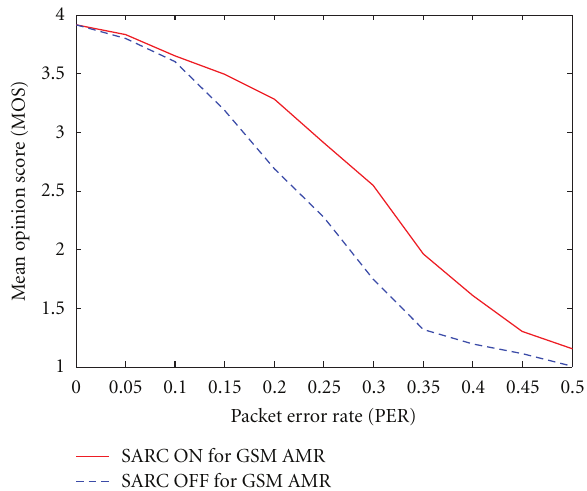
Figure 10: Average TCP Throughput against Packet Error Rate in presence of video